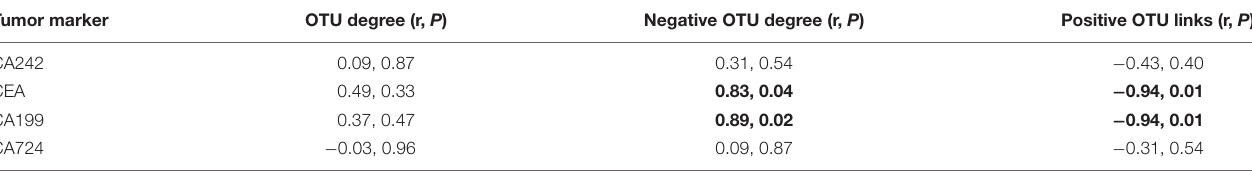
TABLE 3 | The Spearman correlation of tumor markers and OTU degree. Tumor